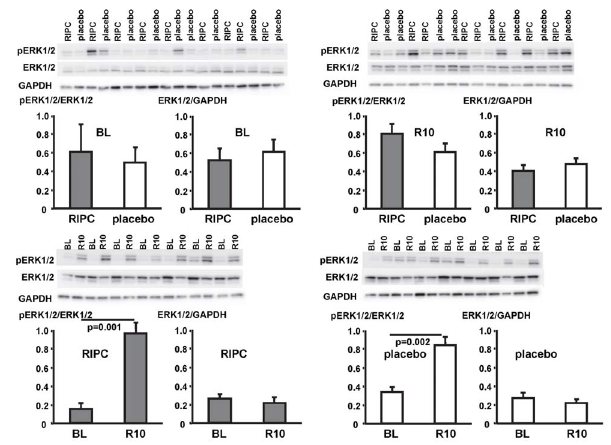
Figure 7. Activation of signal transducer and activator of transcription 5 (STAT5) by ischemia/reperfusion. Original West- ern blots of phosphorylated (p) and total STAT5 content in myocardial biopsies obtained at baseline (BL) before initiation of cardiopulmonary bypass and at 5–10 min reperfusion (R10) from patients undergoing remote ischemic preconditioning (RIPC) or not (placebo). Immunor- eactivitiy of pSTAT5 was normalized to the respective total protein. Ratios are presented in bar graphs.